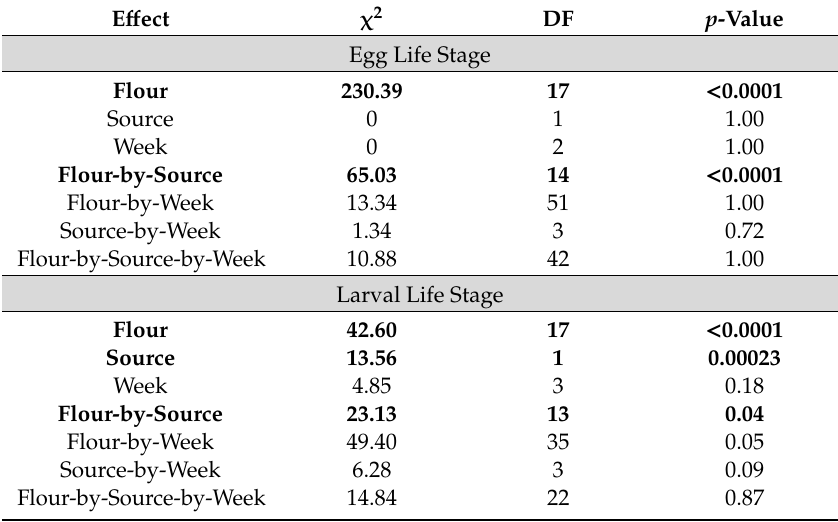
Figure 4. Egg development over time for each flour. The graphs represent emergence data for all sources except, Source 1 corn and Source 2 garbanzo and sorghum. Darker colors represent later life stages of development. Table 5. ANOVA results for egg development over 4 weeks for each life stage independently. Bolded text within the table represents significant effects in the model.